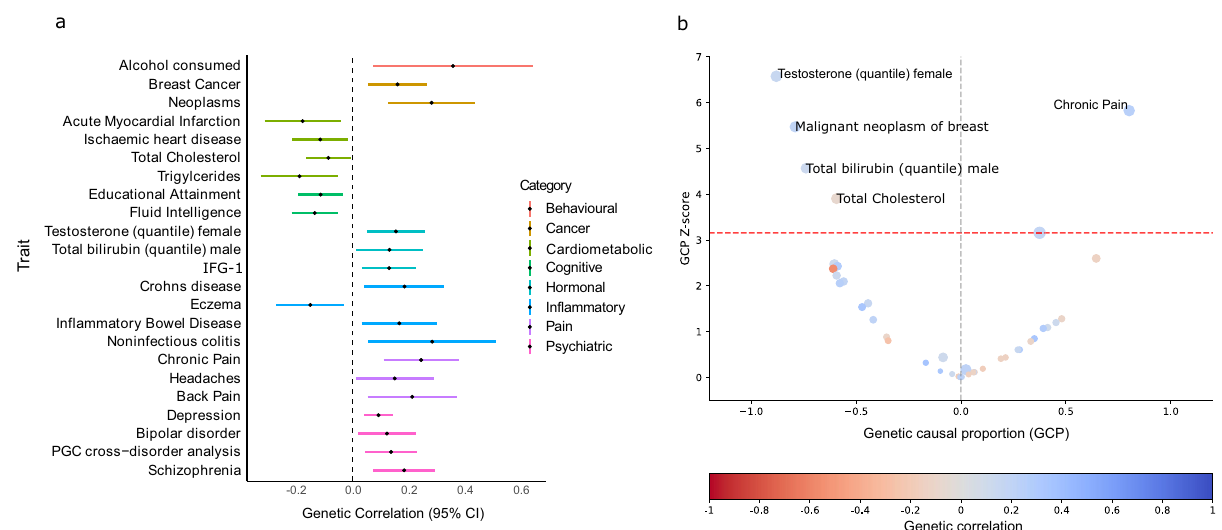
Fig. 2 Genetic correlation and latent causal variable analysis between acne and other complex traits. All analyses were conducted using GWAS summary statistic data from 935 complex traits in the CTG-VL platform. a Black circles represent point estimates of LD score-based genetic correlations. Error bars indicate 95% con fi dence intervals. b Colour bar indicates strength and direction of genetic correlation where red indicates a negative correlation and blue a positive correlation. Red line indicates signi fi cance threshold for multiple testing (FDR < 5%). CI con fi dence intervals, GCP Genetic causal proportion.